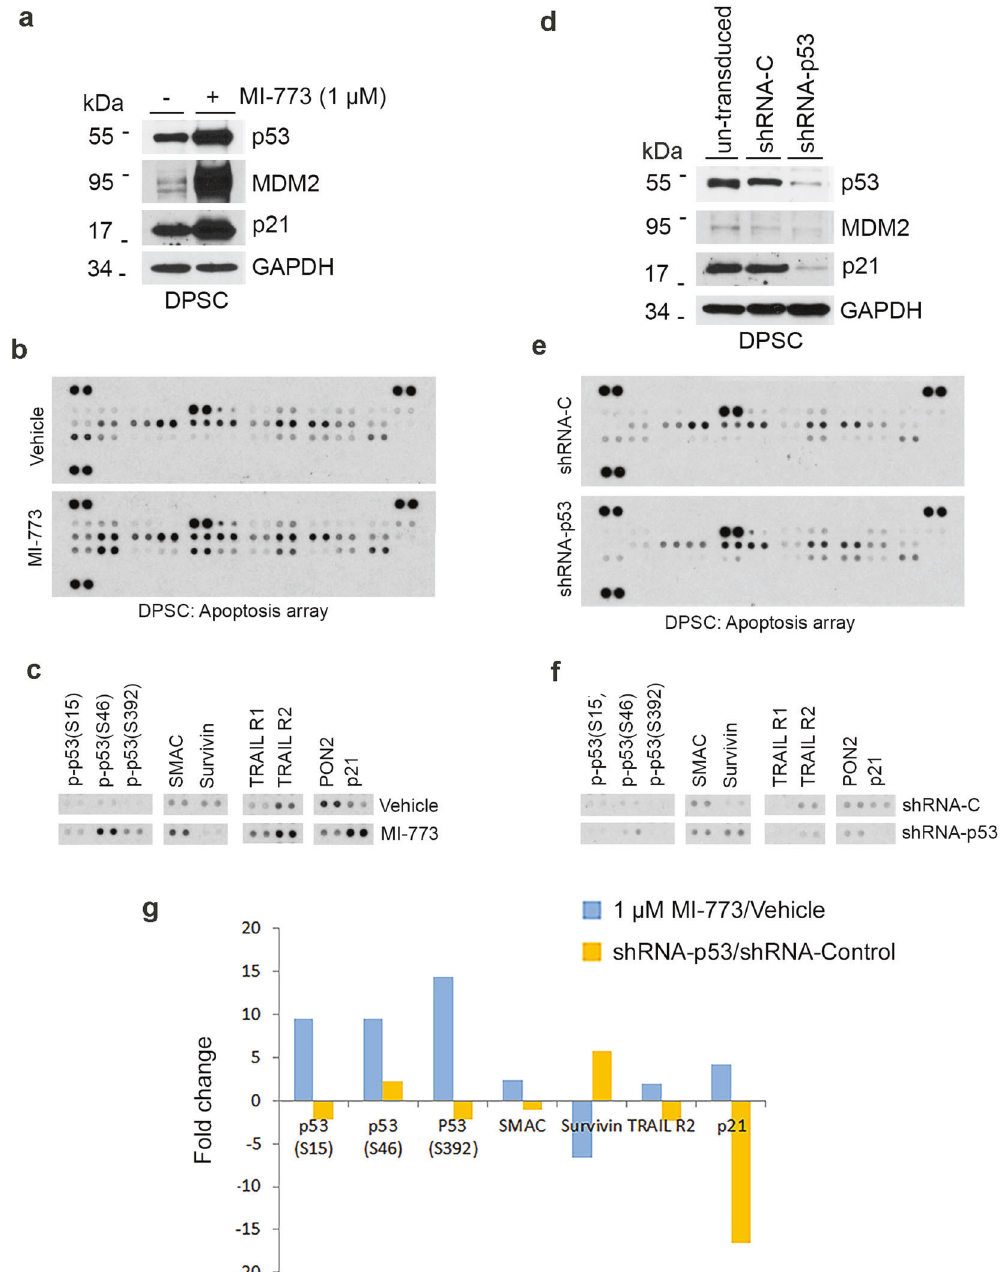
Fig. 7 Expression of downstream targets of p53 in DPSC cells. a DPSC were treated with 1 µM MI-773 (or vehicle control) for 24 hours. Western blots for p53, MDM2, and p21 were used to verify the effect of MI-773 treatment on p53. b , c Protein arrays for evaluation of MI-773- treated DPSC versus control-treated DPSC. c Selected genes from b (full results are in Suppl Table 1). d DPSC were stably transduced with shRNA-control or shRNA-p53. Westerns blot for p53, MDM2, and p21 to verify the effect of shRNA constructs. e , f Protein array for evaluation of shRNA-p53 transduced DPSC versus shRNA-Control-transduced DPSC. f Selected genes from e (full results are in Suppl Table 2) . g Graph depicting the fold change in protein density from MI-773/vehicle from MI-773/vehicle c and from shRNA-p53/shRNA-control f showing inverse correlations in several p53 targets (e.g., p21, SMAC, and